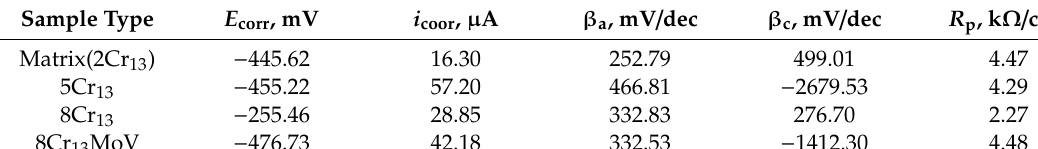
Figure 11. Potentiodynamic polarization curve of the substrate and overlay in 3.5% NaCl solution. Table 8. Electrochemical parameters related to the substrate and each surfacing layer.